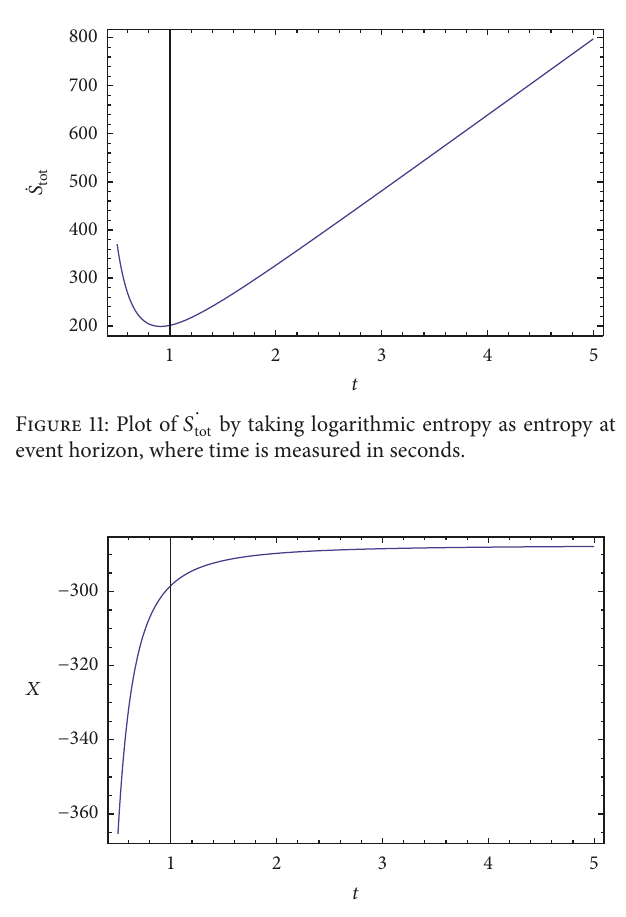
̈𝑆 Figure 12: Plot of 𝑋 = tot by taking logarithmic entropy as entropy at event horizon, where time is measured in seconds.